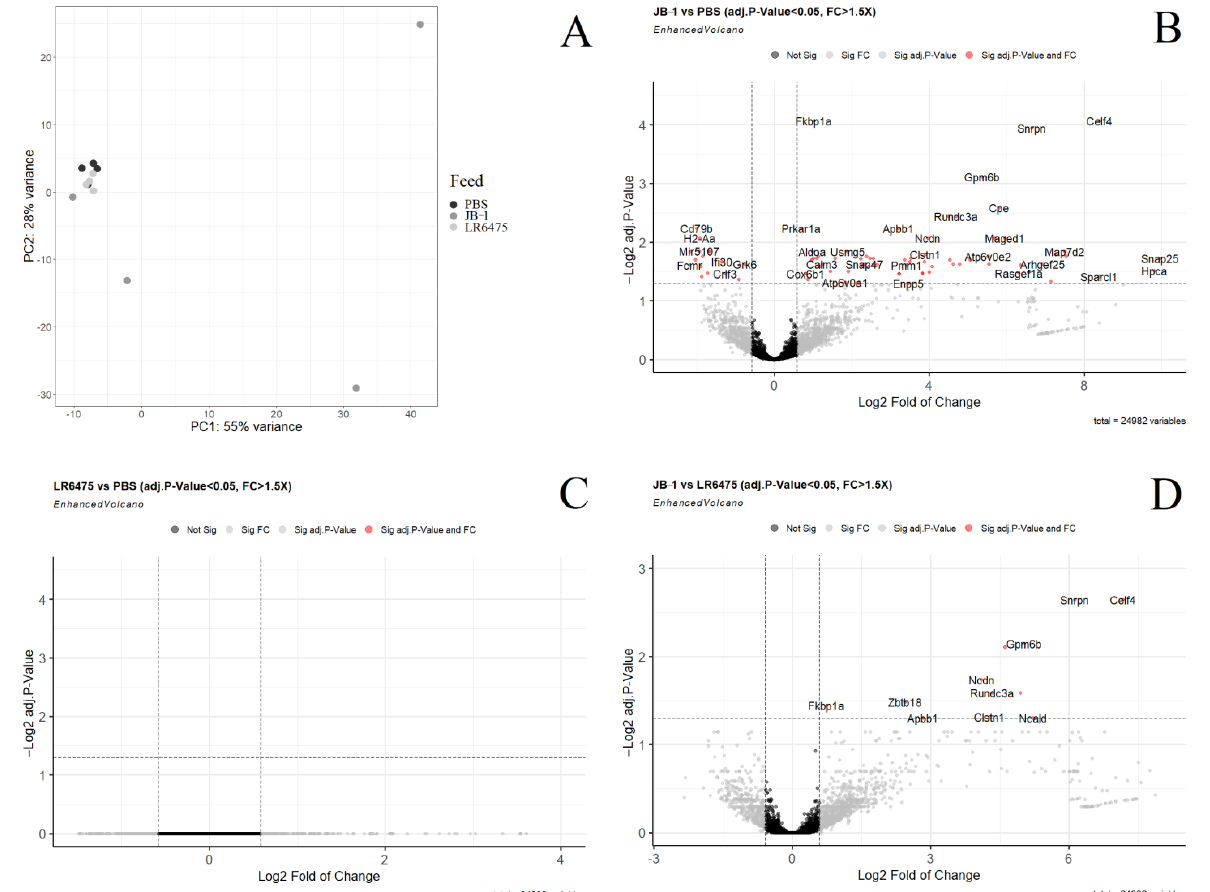
Figure 1. Differential expression analysis of mRNA measured by RNAseq in the blood of mice fed either Lacticaseibacillus rhamnosus JB-1, Limosilactobacillus reuteri 6475, or PBS. ( A ) Principal component analysis of all three treatment groups. ( B ) Volcano plot showing individual differentially expressed genes in a comparison of JB-1 vs. PBS-fed mice. ( C ) Volcano plot showing individual differentially expressed genes in a comparison of LR6475 vs. PBS-fed mice. ( D ) Volcano plot showing individual differentially expressed genes in a comparison of JB-1 vs. LR6475-fed mice. Genes with a positive log fold change are more highly expressed.